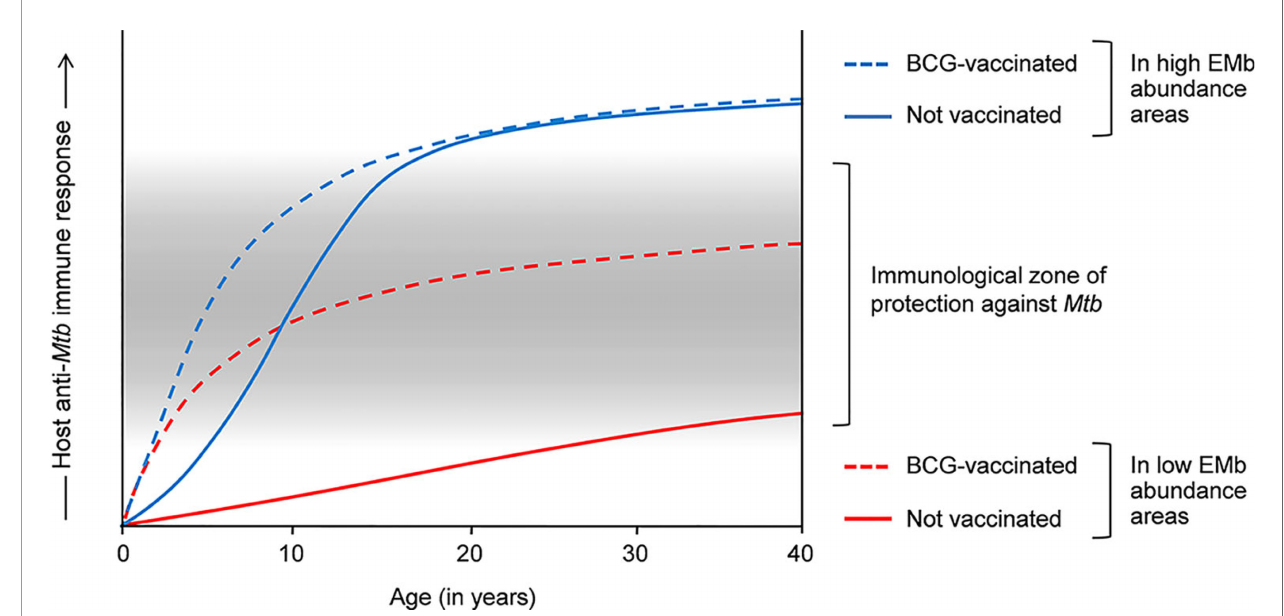
FIGURE 1 | Effects of environmental mycobacteria (EMb) and BCG on the host response to Mtb and the cross-talk thereof. Host response to Mtb is complex and heterogeneous. Infants and young children have a poorly developed immune system, which is incompetent in containing Mtb infection. BCG vaccination in these people promotes T H 1 responses to Mtb , resulting in the effective containment of the bacilli and signi fi cant protection against childhood TB (dashed blue and red lines). Owing to the presence of cross-reactive antigens, EMb also activate a degree of immunity against Mtb and therefore, confer some protection against childhood TB (blue line). However, frequent EMb exposure leads to the aggravation of anti- Mtb immunity in immunocompetent adults, which drives TB pathogenesis and results in higher incidence of pulmonary TB in the tEMb-abundant areas (normal blue line). Similar aggravation of anti- Mtb immunity occurs in BCG-vaccinated adults in the EMb-abundant areas and leads to higher incidence of adult pulmonary TB and low ef fi cacy of BCG in these places (dashed blue line). On the other hand, owing to low EMb exposure, BCG-mediated immunity against Mtb is not substantially modulated in the adult inhabitants in the areas of lower EMb abundance (dashed red line). Accordingly, vaccinated adults exhibit a moderately intense anti- Mtb immune response, which confers signi fi cant protection against adult pulmonary TB in these